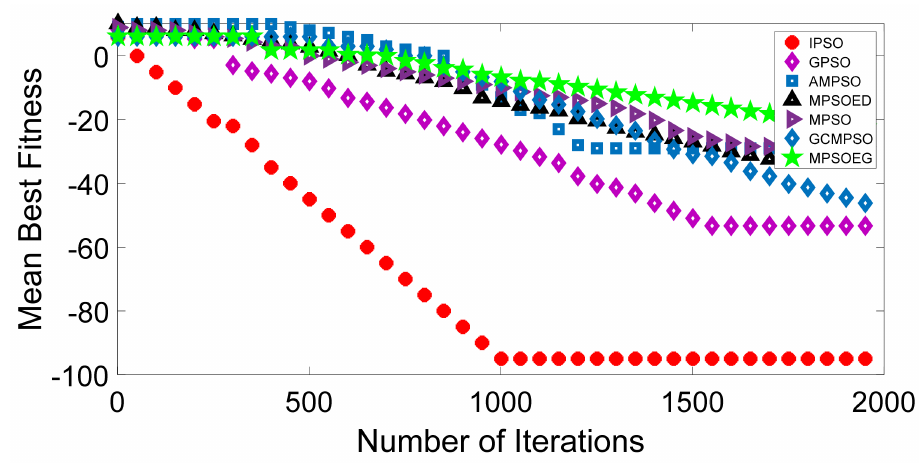
Figure 3. Algorithms convergence plots on f 7